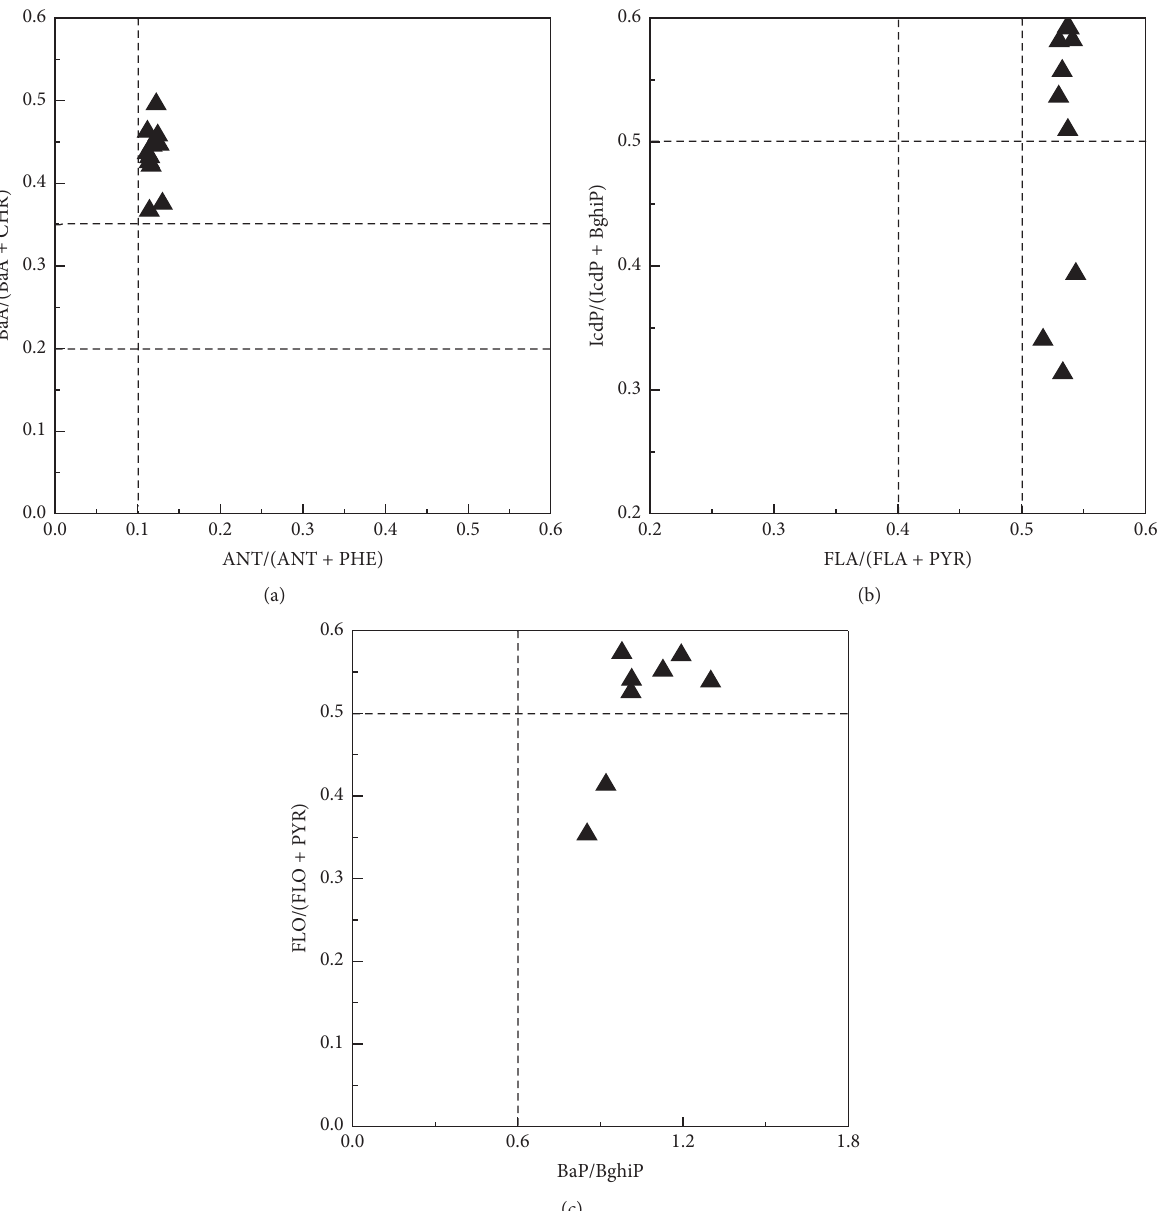
Figure 2: Scatter diagrams for diagnostic